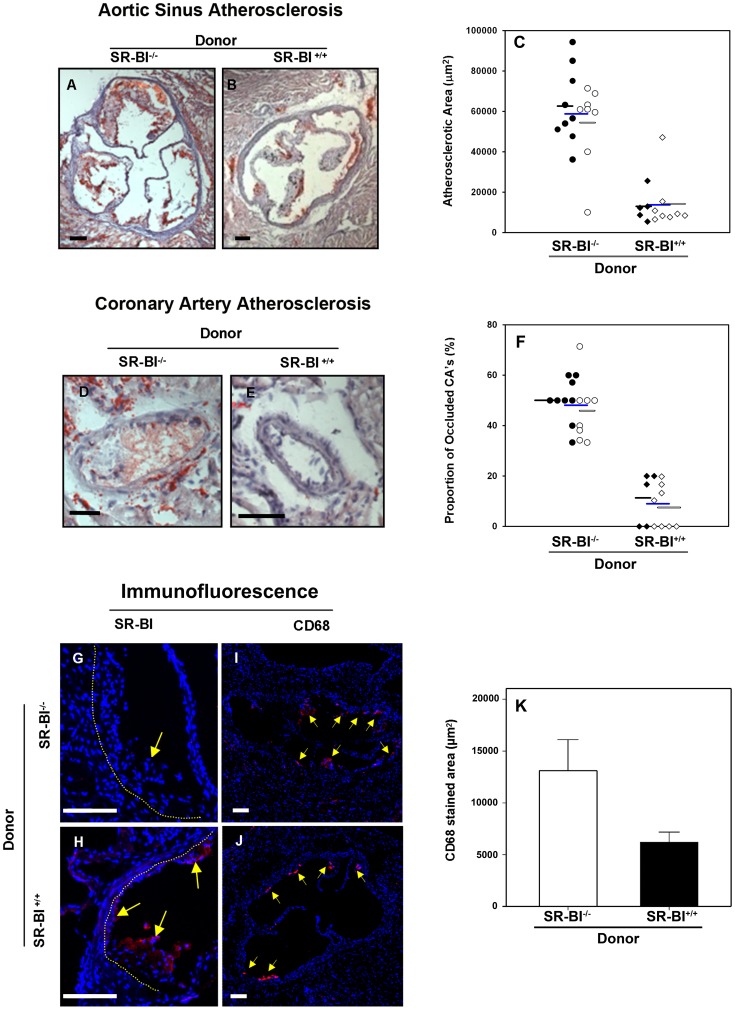
Restoration of SR-BI expression in BM derived cells by BM transplantation reduces diet induced atherosclerosis in SR-BI-null/apoE-hypomorphic mice.SR-BI−/−apoE-hypomorphic mice, at 10 weeks of age, were transplanted with BM from either control SR-BI−/− or SR-BI+/+ mice to generate SR-BI−/− → SR-BI−/− (circles) and SR-BI+/+→ SR-BI−/− mice (diamonds). BM transplanted mice were fed a high fat, high cholesterol, cholate containing (HFCC) diet for four weeks. A–C: Aortic sinus atherosclerosis. Representative oil red O and hematoxylin stained sections of the aortic sinus are shown in panels A and B for mice transplanted with BM from SR-BI−/− or SR-BI+/+ donors. Scale bars = 100 µm. C. Atherosclerotic plaque sizes were quantified for n = 17 SR-BI−/− → SR-BI−/− and n = 13 SR-BI+/+→ SR-BI−/− mice. Donor BM is indicated. P<0.001 by the Mann Witney rank sum test. D–F: Coronary artery atherosclerosis. Representative images of oil red O and hematoxylin stained coronary artery sections are shown in panels D and E. Scale bars = 50 µm. F. Coronary arteries in heart sections were scored as “occluded” if they contained raised atherosclerotic plaques and the proportions of occluded coronary arteries are plotted. Group sizes are as for Panel C. P = 3×10−9 by Student’s T-test and P<0.001 by the Mann Witney rank sum test. For panels C and F, male and female mice are indicated by closed and open symbols respectively. Averages are indicated by bars: black bars  =  males, open bars  =  females, blue bars  =  pooled males and females. Data for males vs females were not statistically significantly different. Immunostaining (red) for SR-BI (G, H) or CD68 (I, J) in atherosclerotic plaques from a separate group of female SR-BI−/− → SR-BI−/− mice (G, I) and SR-BI+/+→ SR-BI−/− mice (H, J) fed the HFCC diet for 18 days. Representative images are shown. Yellow arrow in G points to SR-BI negative cells; yellow arrows in H-J indicate cells positive for SR-BI or CD68. Nuclear DNA was stained with DAPI. Scale bars = 100 µm. K. Quantification of CD68 staining area in n = 6 mice per group (all females). Data are means ± standard errors. P = 0.039 by Student’s T-test.